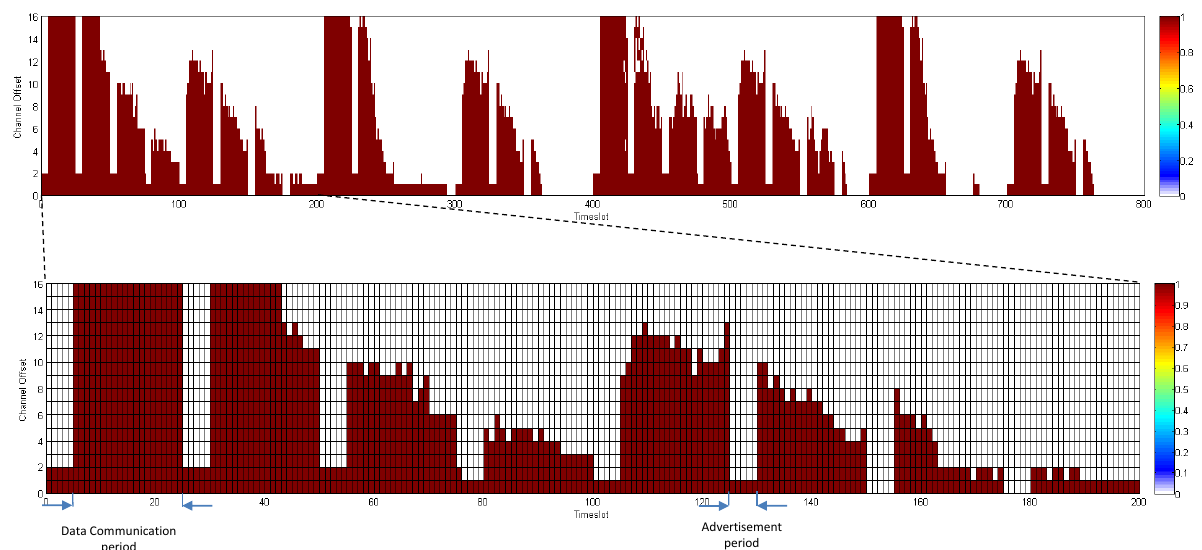
Figure 21. The global matrix of the current slot/channel usage (the advertisement period is also considered for the WirelessHART network to ensure a fair comparison of communication resources) for the sample WirelessHART